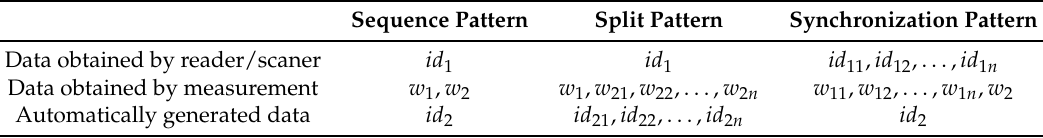
Table 1. Data entities of basic manufacturing process